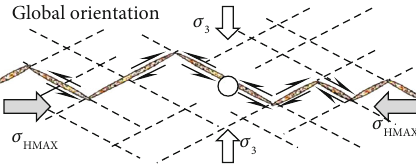
Figure 25: Schematic of the global orientation of fracture propagation in naturally fractured formation